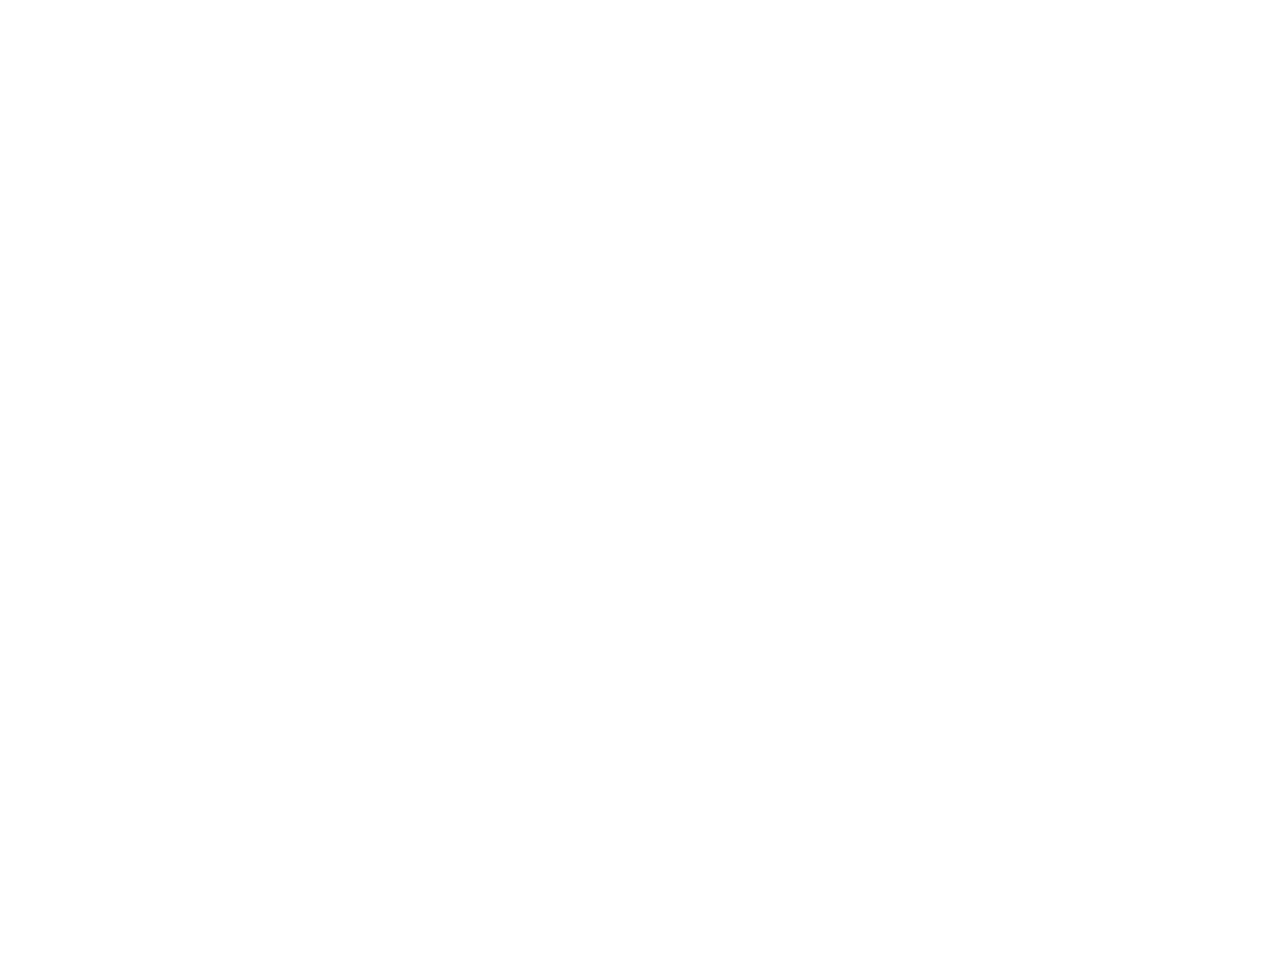
Frontiers in Genetics | Genetics of